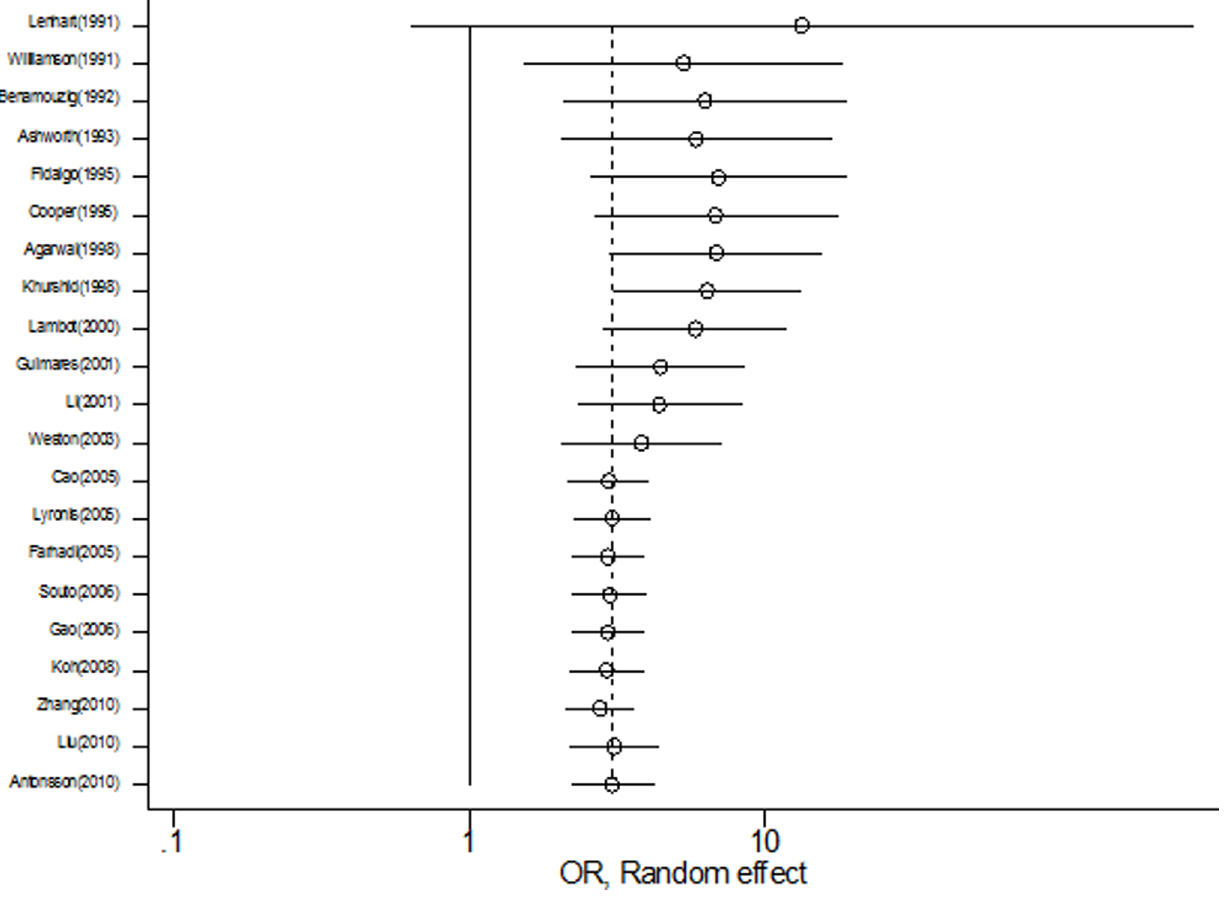
Figure 3. Cumulative meta-analysis of case control studies for the evidence of HPV involvement in OSCC. doi:10.1371/journal.pone.0069238.g003 PLOS ONE |